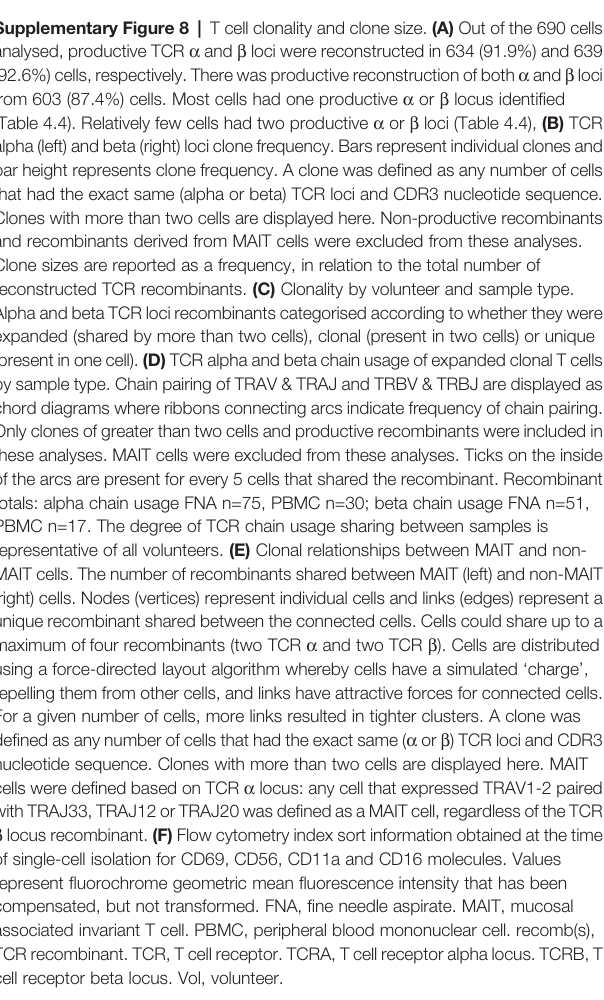
Supplementary Figure 4 | Expression of TRM markers on FNA TRM and PBMC TRM-like cells. TRM/TRM-like cell expression of the selected markers was